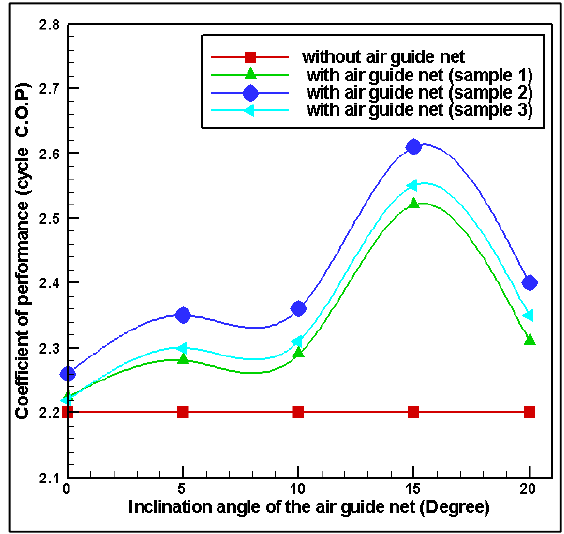
Fig. 8. Variation of cycle C.O.P with inclination